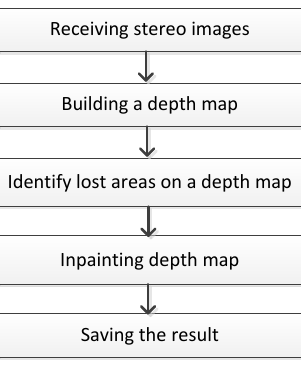
Fig. 1. Block diagram of the proposed algorithm